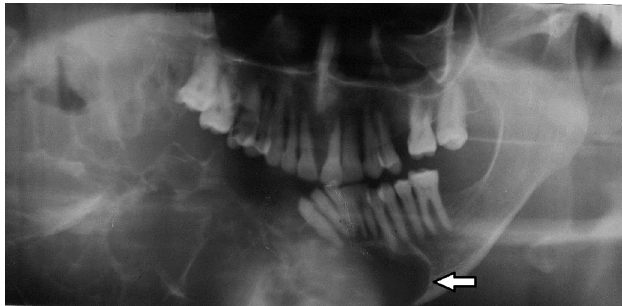
Fig. 5. Pantomograph showing multilocular lesion with a spider-like appearance of an ameloblastoma in the mandible.